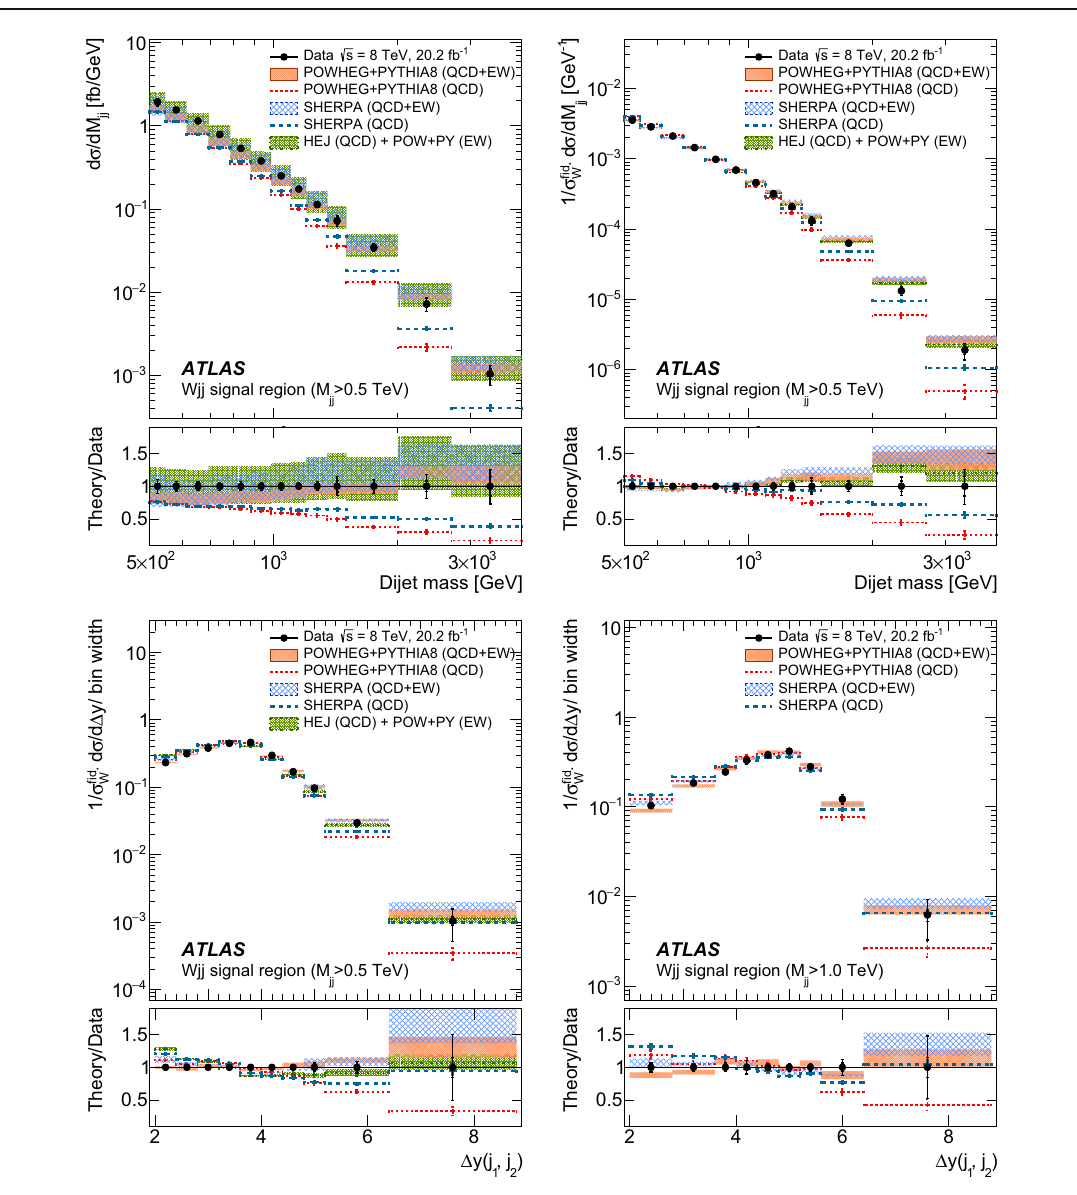
Fig. 16 Top Unfolded absolute ( left ) and normalized ( right ) differ- ential W jj production cross sections as a function of dijet mass for the signal fiducial region. Bottom Unfolded normalized production cross sections as a function of (cid:6) y ( j 1 , j 2 ) for the signal regions with